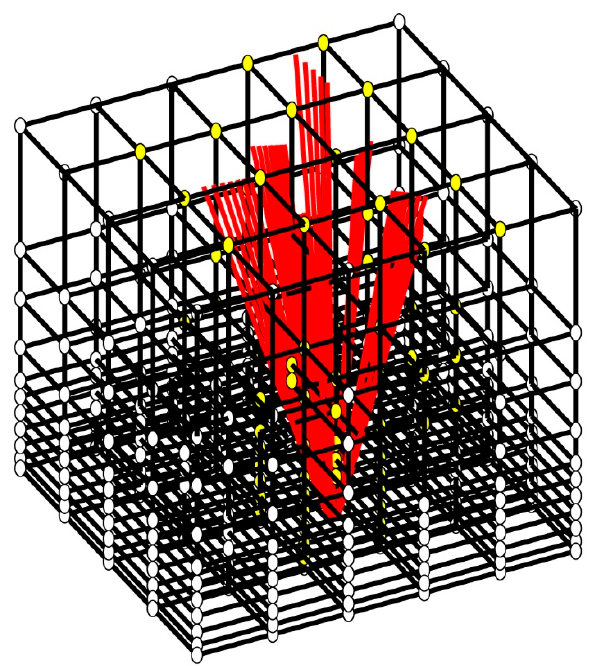
Figure 1. Global Navigation Satellite System (GNSS) signals (red lines) from single GNSS station for GNSS tomography—the cuboid is the tomographic region adopted in general node parameterization approaches, the yellow solid nodes are those near GNSS signals and the hollow nodes are those in the empty region.